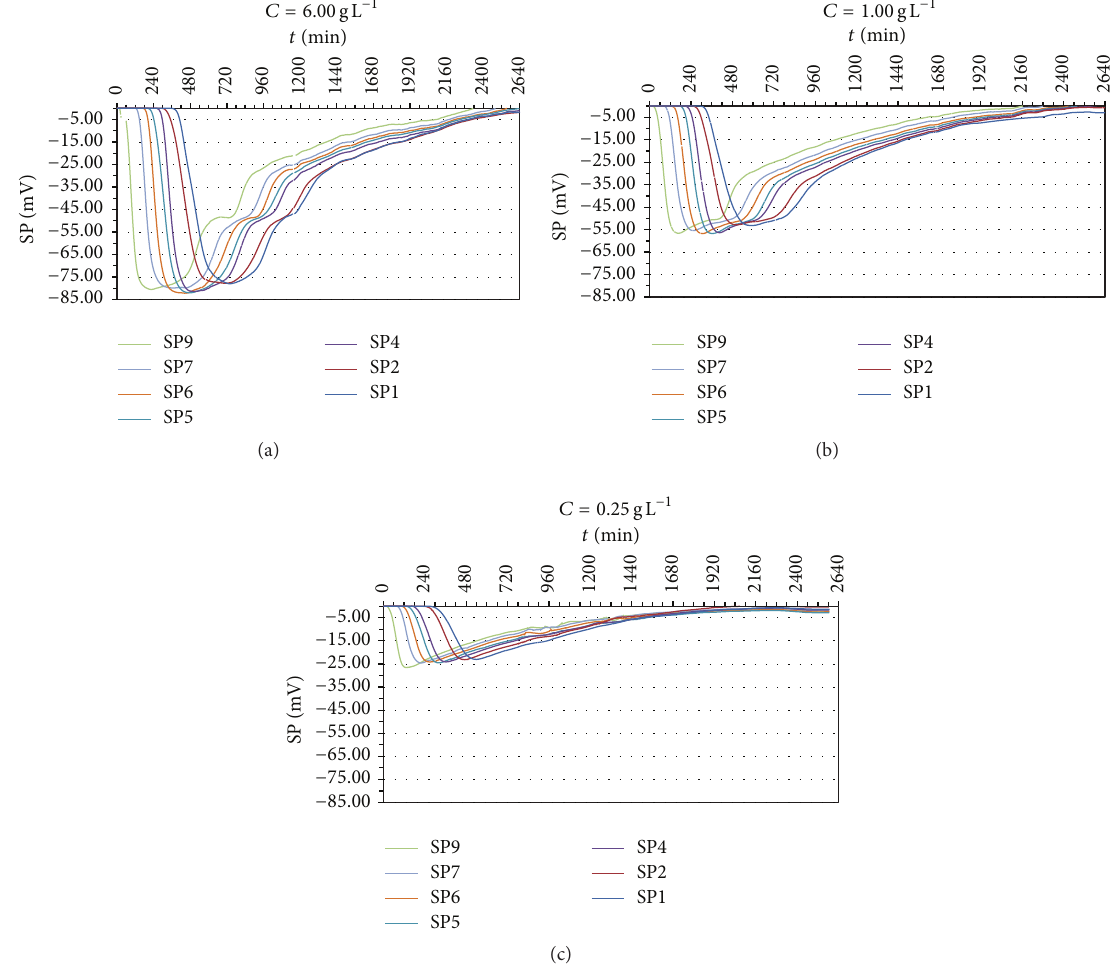
On the contrary, the boundary condition at the bottom of the column ( 𝑥 = 0 m) is atmosphere/gauge for the Fluid Flow module and outflow for the Solute transport one. Finally, the sides boundaries are characterized by no flow and no flux